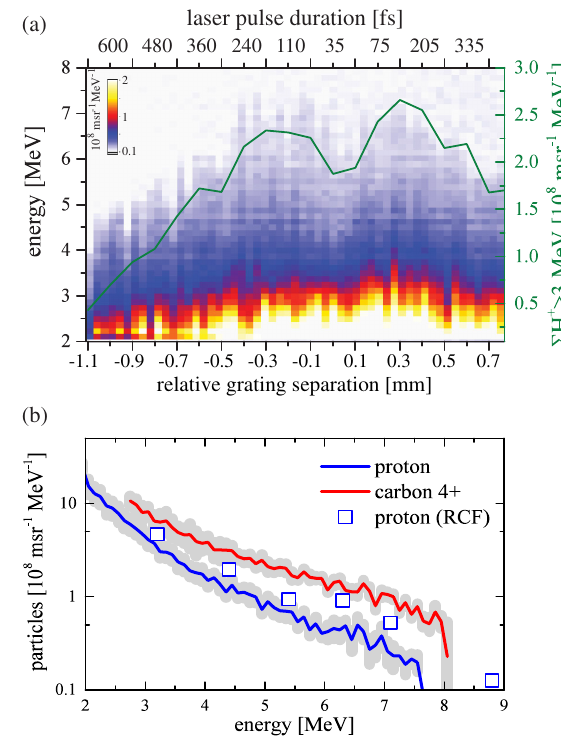
FIG. 2. Results from tape drive: (a) Waterfall plot of proton spectra as a function of relative compressor separation, i.e., laser pulse duration (positive grating separation corresponds to neg- ative chirp and vice versa). The green line gives the integrated number of protons with energies above 3 MeV. (b) Proton (blue line), C 4 þ (red line) spectra averaged over 15 shots for a pulse duration of 120 fs and proton counts from radiochromic film (RCF) on the spectrometer axis (blue squares). The standard deviation from shot-to-shot variations is shown in grey for each